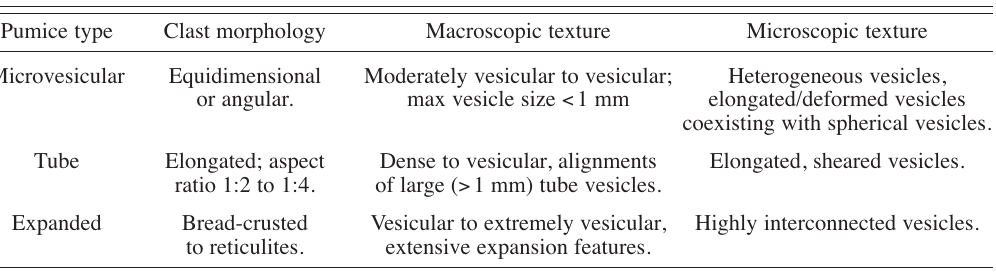
Table I. Pumice types from AMS eruption.